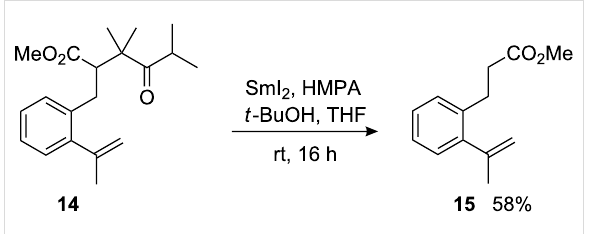
cyclization product. Remarkably, the orientation of the methyl Scheme 7: Reductive fragmentation of highly hindered ketoester 14